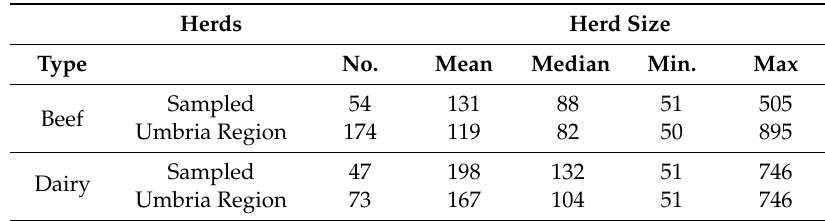
Table A2. No. of farms and farm size (mean, median, minimum, and max) per breeding type in the sampled farms and in Umbria Region in the same